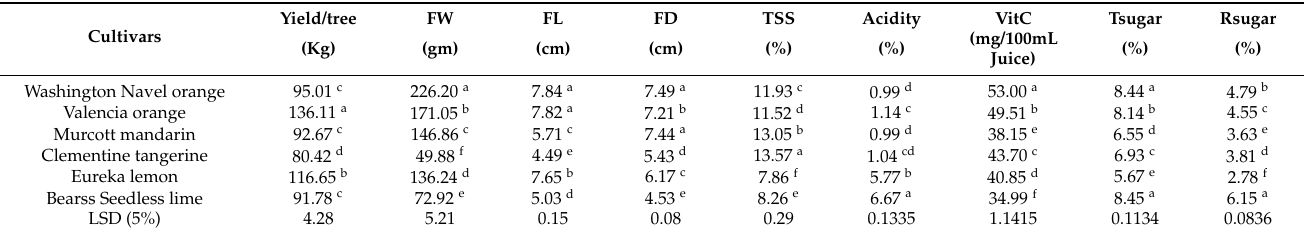
Table 3. Distribution of mean values of yield, fruit weight (FW), fruit length (FL), fruit diameter (FD), TSS, Acidity, Vitamin C (VitC), total sugar (Tsugar), and reducing sugar (Rsugar) of six cultivars of mature citrus in the investigated